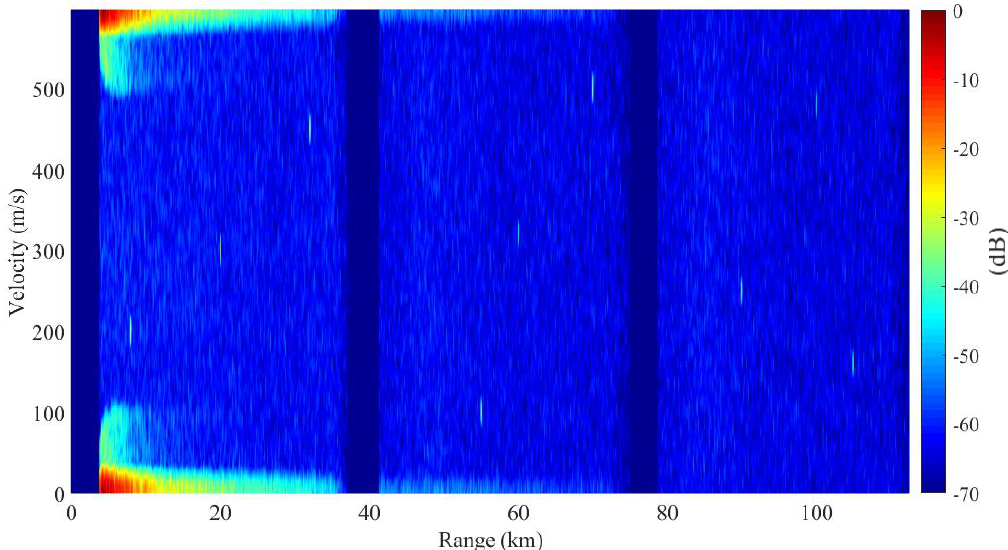
Figure 10. Range-Doppler resolution for the complete PD process.